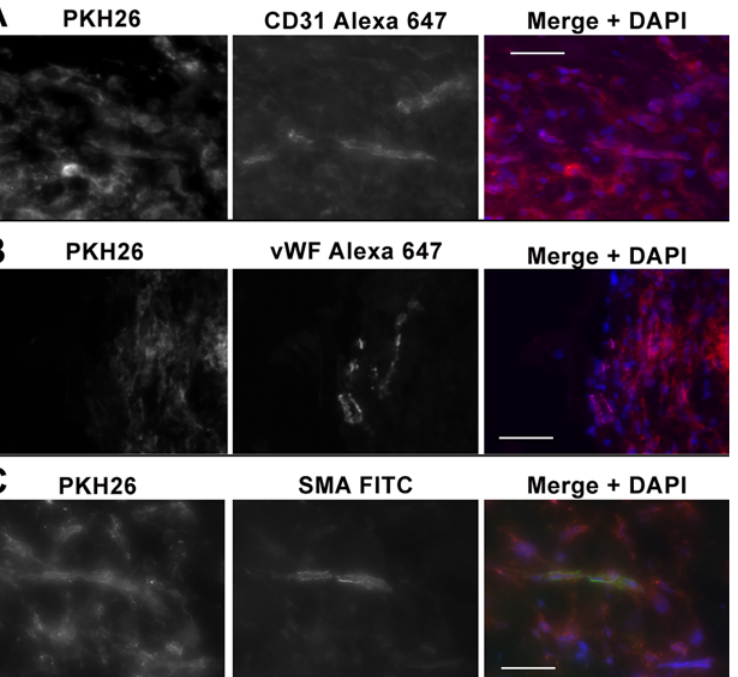
Figure 6. EC of the skeletal muscle form microvessels in matrigel injected subcutaneously over the dorsum. A–B, Tissue sections of the matrigel plug recovered from the dorsal skin of C57BL6 mice analyzed 14 days post injection reveal microvessel formation. Staining for anti-CD31 and anti-vWF followed with a secondary Alexa 647 antibody highlight mature vessels formed within the matrigel by injected cells (PKH26 + ). C, Conjugated FITC anti-SMA staining indicates the recruitment of endogenous smooth muscle cells in the formation of microvessels. Scale bar=50 m m.